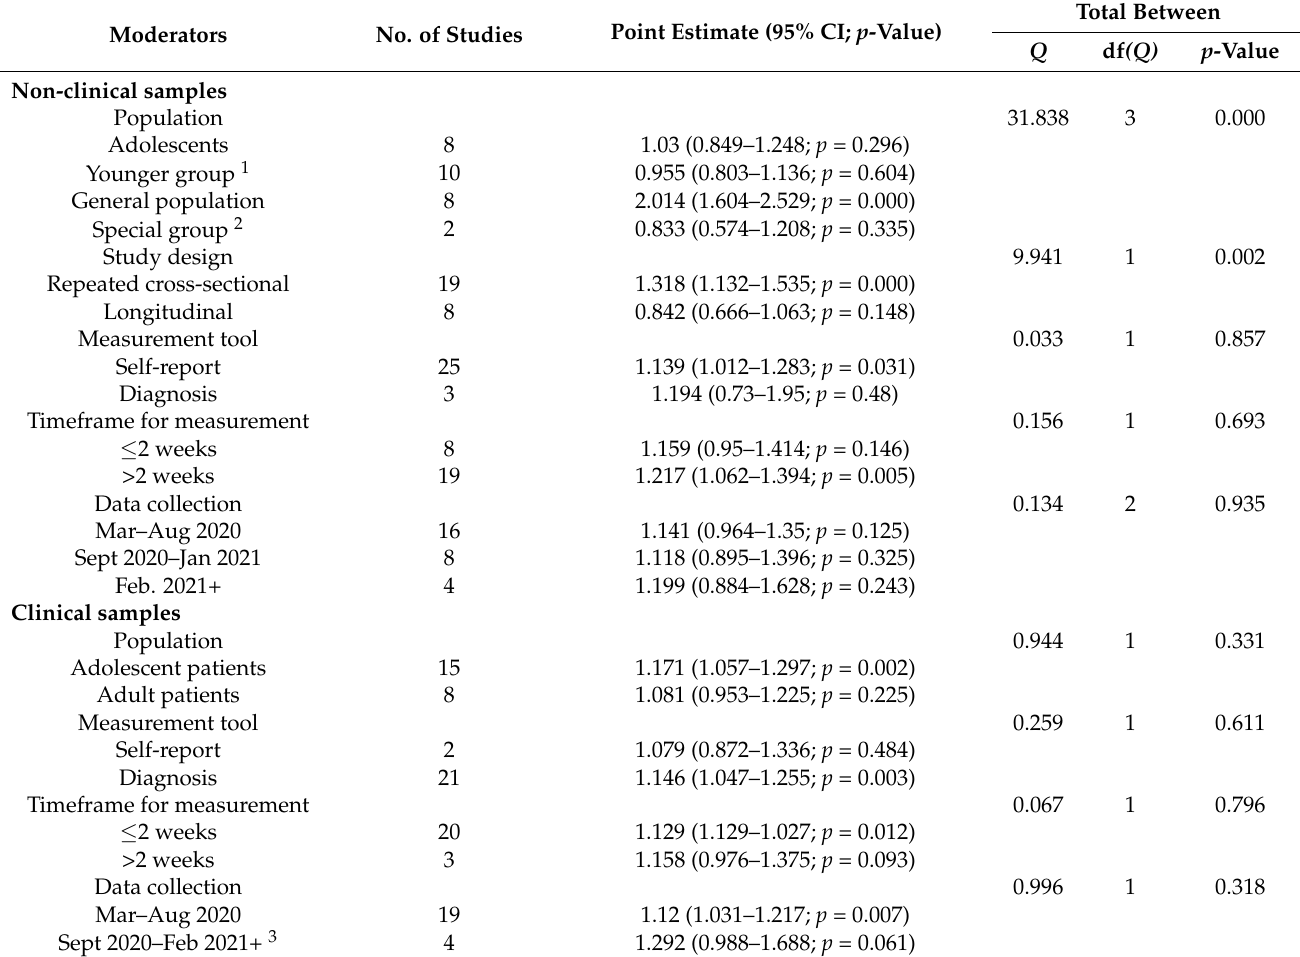
Table 4. Summary of subgroup analysis for non-clinical and clinical samples reporting suicidal